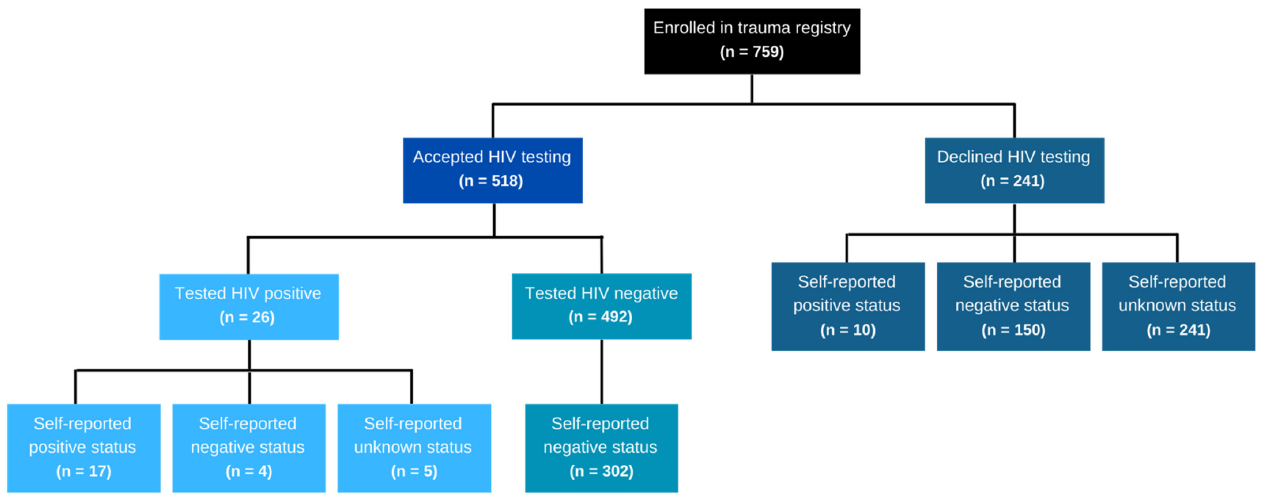
Figure 2. ED injury patient population stratified by HIV status (‘n’ indicates number of